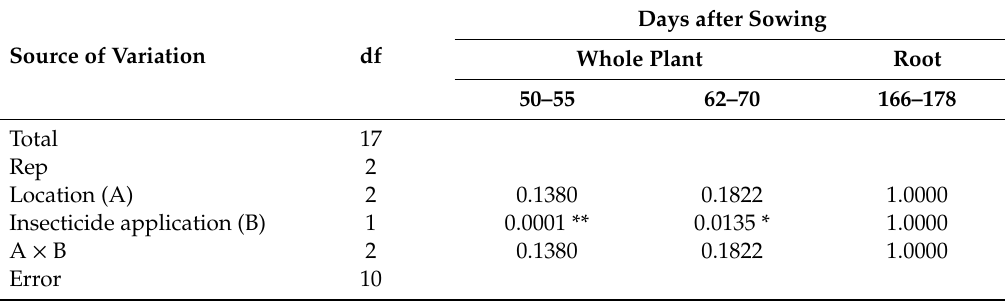
Table 10. Thiamethoxam (including chlothianidin) residues in the whole plants during the first three observing periods and for roots at harvesting in 2016.